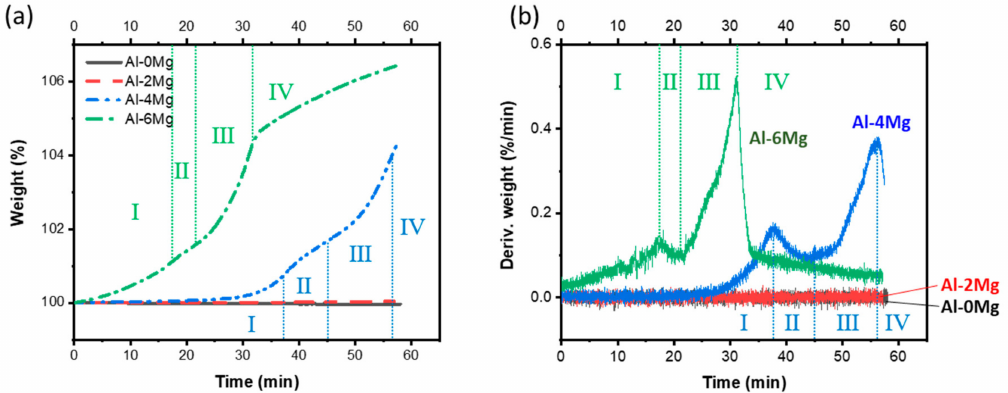
Figure 9. ( a ) weight percent profiles and ( b ) their derivatives in Al-Mg alloy samples vs hold time at 800 ◦ C, as measured using thermogravimetric / di ff erential thermal